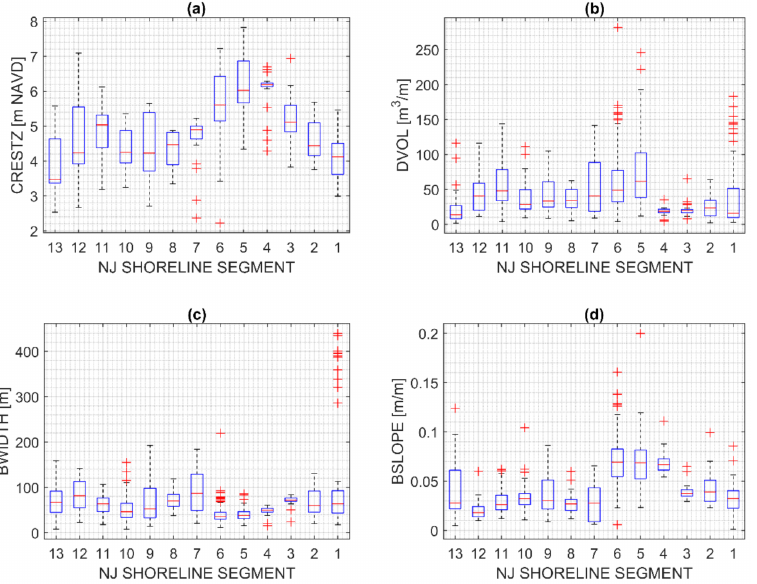
Figure 2. Spatial variance for select Resilience parameters by segment. ( a ) Dune crest elevation; ( b ) Dune volume; ( c ) Berm width; ( d ) Beach slope. Presented by segment, south (13) to north (1). Red horizontal bar—median value, blue box—25th and 75th percentiles. Outliers defined by 1.5 × IQR away from 25th/75th percentiles. Courtesy of